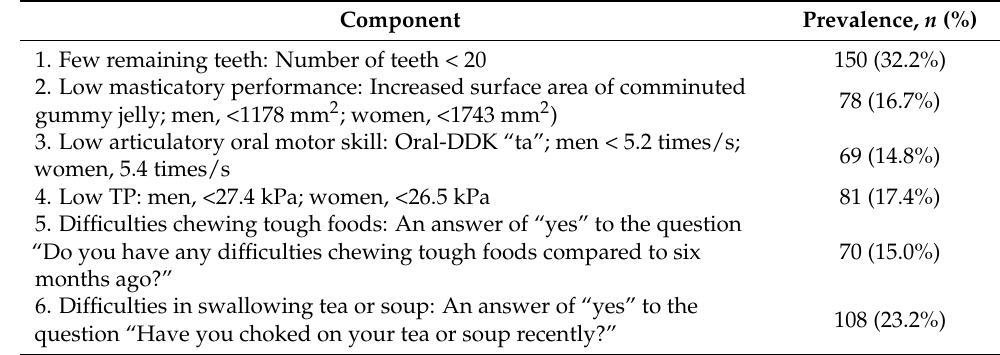
Table 1. Six components of oral frailty used in this